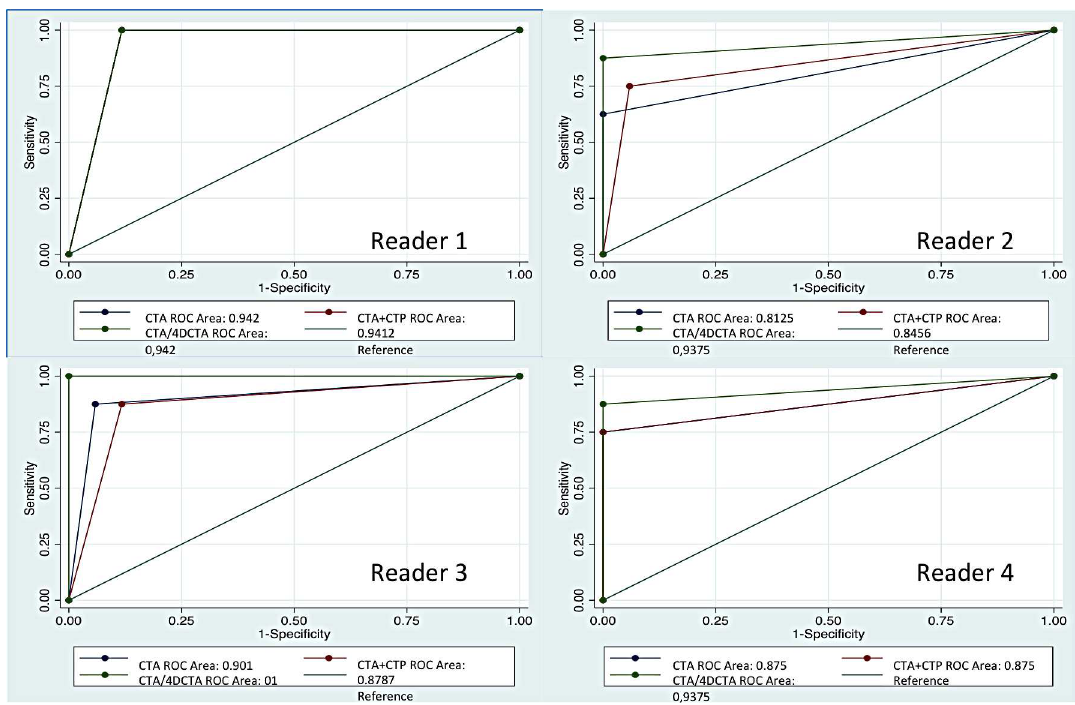
Fig 2. ROC curves and area under the curve (AUC) for diagnostic performance. Four different readers, comparing CTA alone, CTA + CTP, and CTA, CTP and 4DCTA.